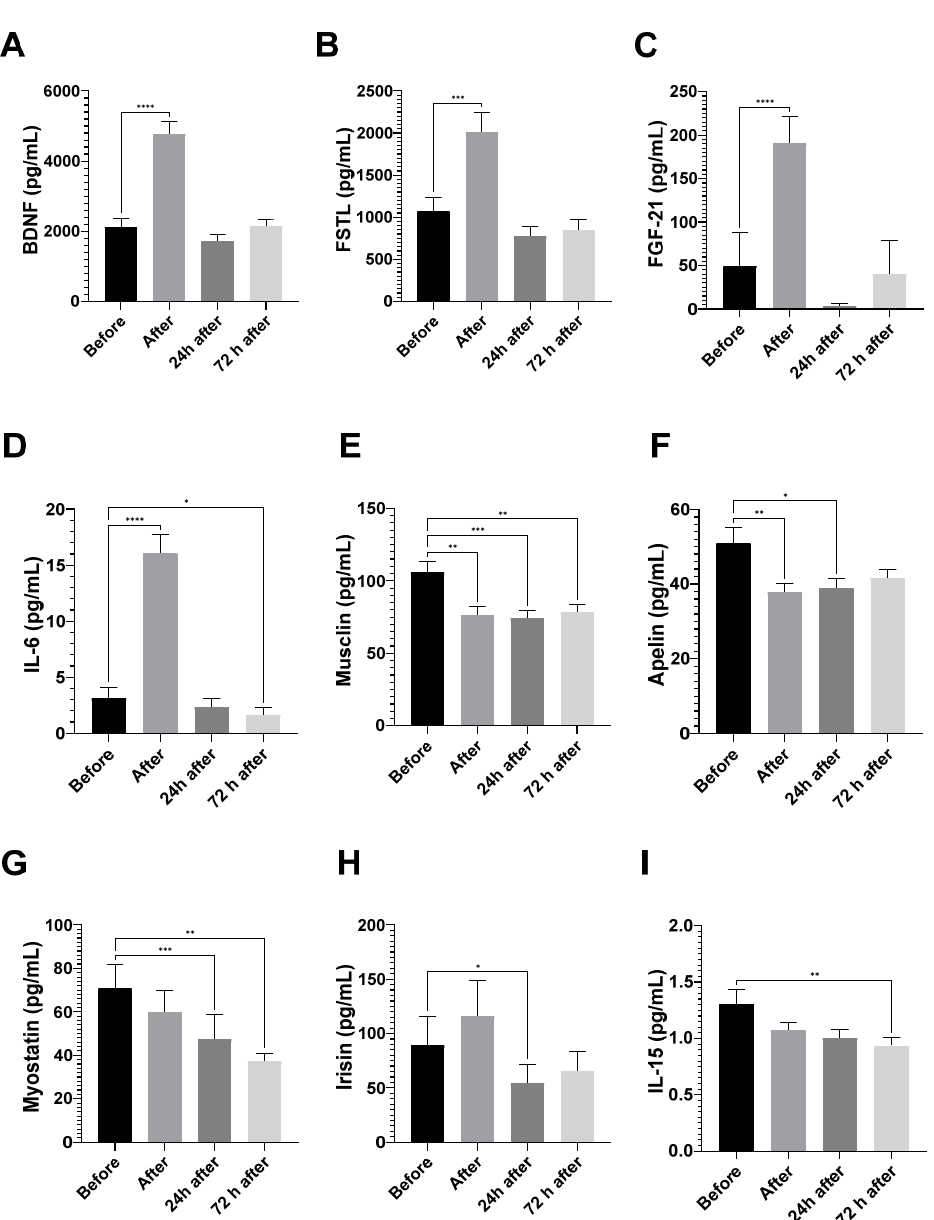
Figure 2. Myokine levels after the marathon race. The BDNF ( A ), FSTL ( B ), FGF-21 ( C ), IL-6 ( D ), musclin ( E ), apelin ( F ), myostatin ( G ), irisin ( H ), and IL-15 ( I ) levels are presented as mean ± EPM of 60 runners before the race, and 24 and 72 h after the race. * vs. before p < 0.05; ** for p < 0.01; *** vs. before p < 0.001; and **** vs. before p < 0.0001.